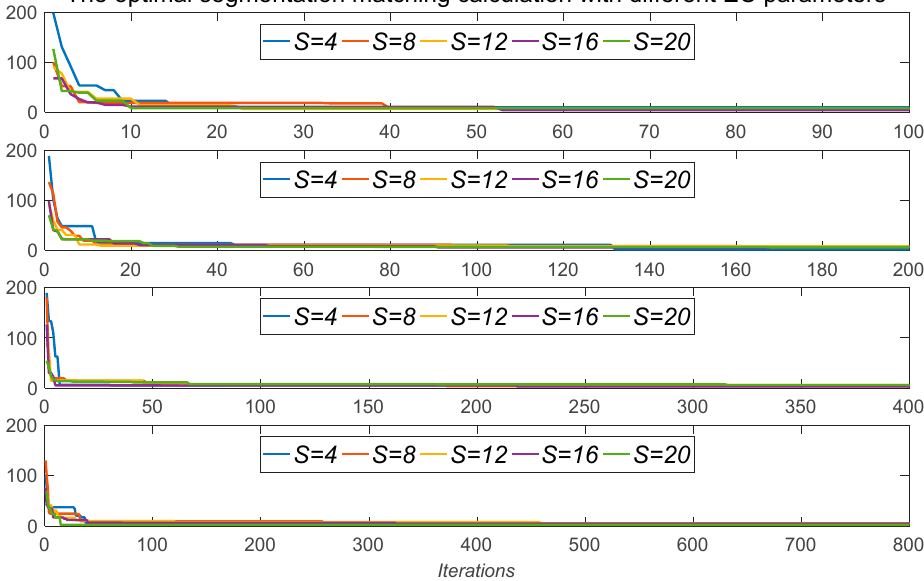
Table 3. Proposal parameter K with different data points of the reference signature.